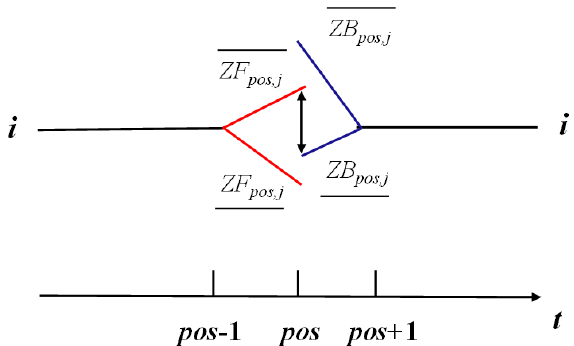
Figure 7. Schematic diagram for improved mutation operation.